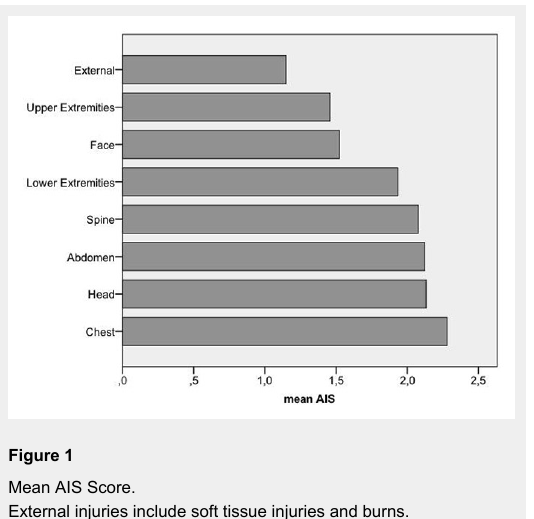
Figure 1 Mean AIS Score. External injuries include soft tissue injuries and burns.